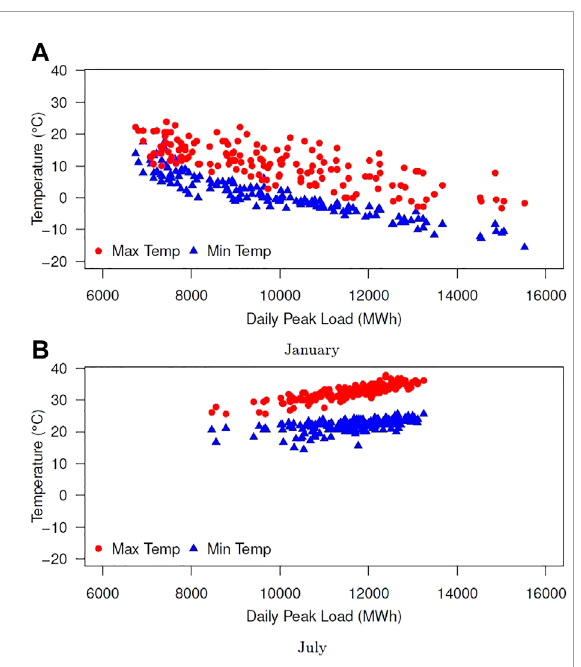
FIGURE 3 Daily peak load vs daily maximum and minimum temperature in (A) January and (B)